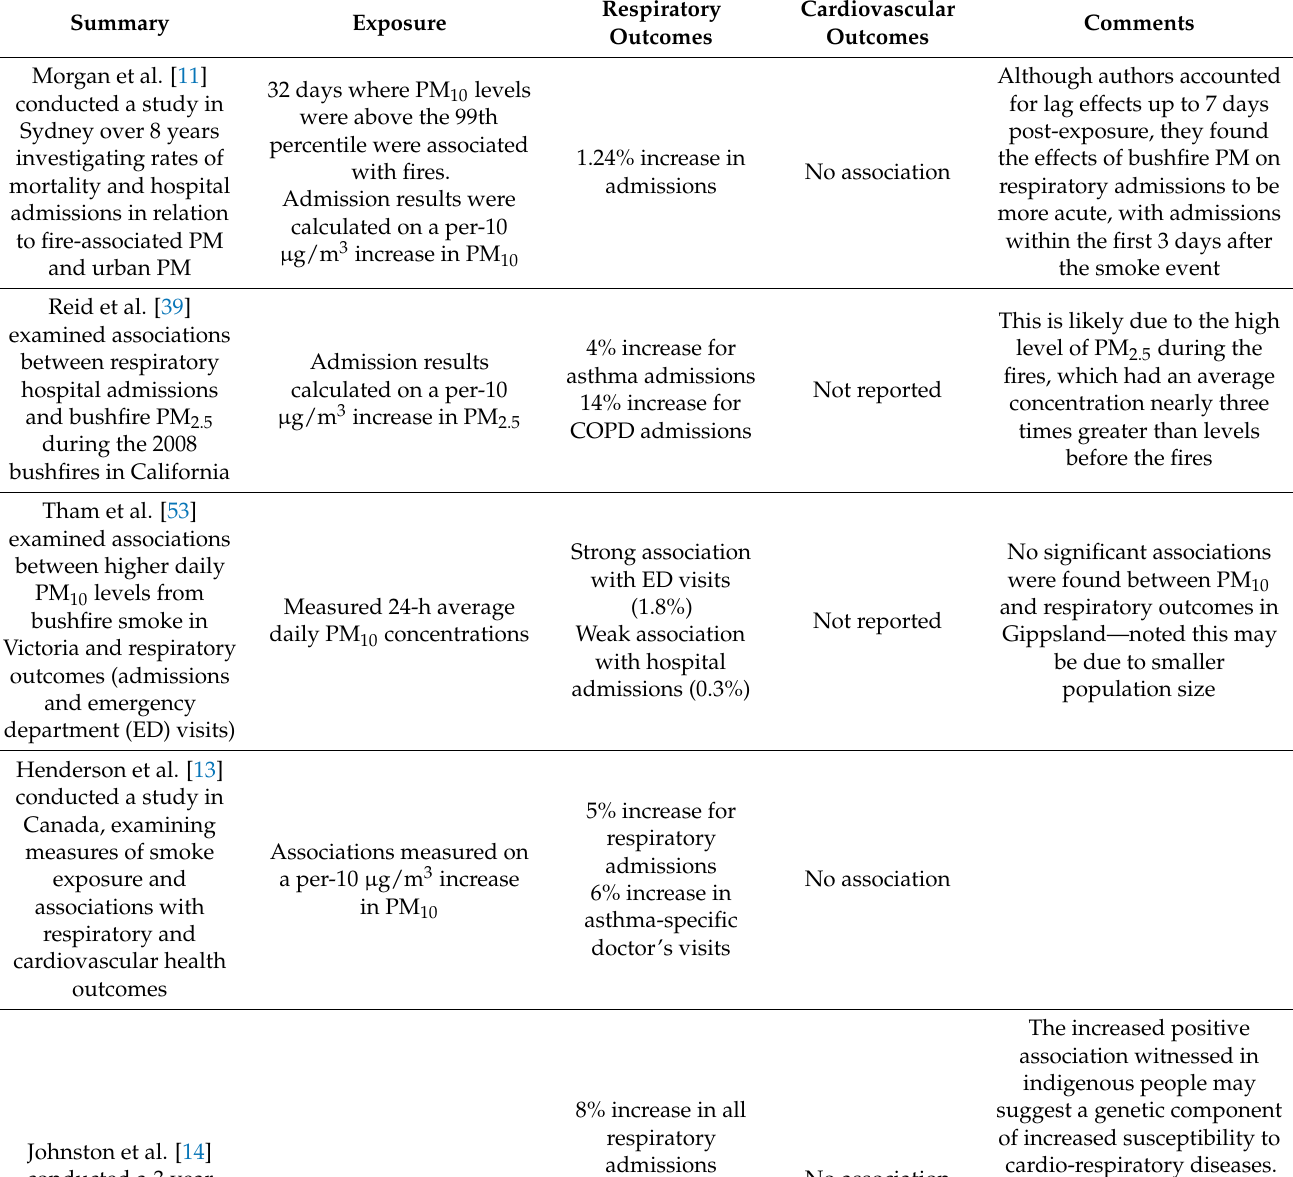
Table 3. Summary of studies investigating PM and respiratory and/or cardiovascular outcomes